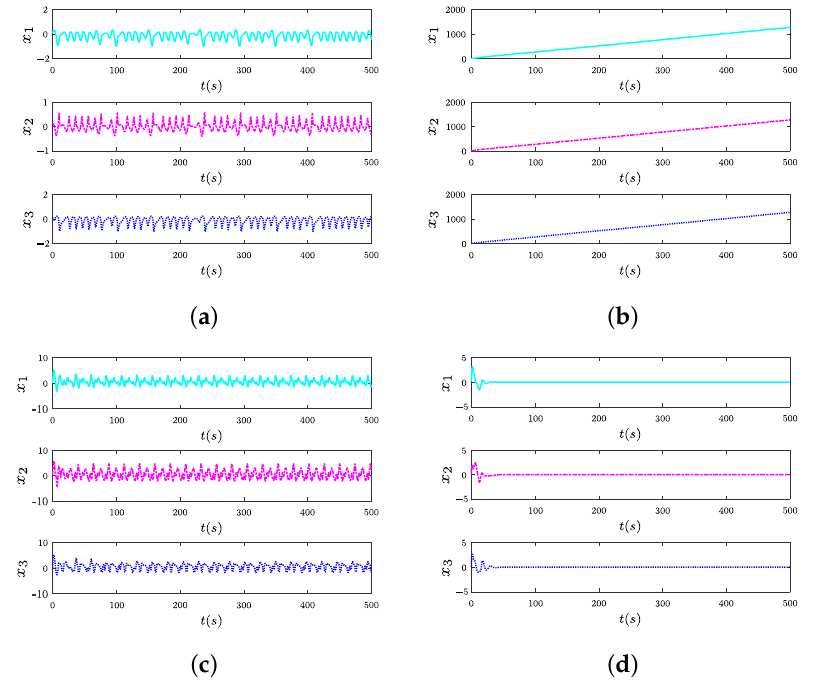
Figure 7. State trajectories of the original SFM system and the SFM under controller (40), controller (42) and controller (44) from X ( 0 ) = [ 0.1,0.1,0.1 ] T . ( a ) Original SFM system; ( b ) By controller (40); ( c ) By controller (42); ( d ) By controller